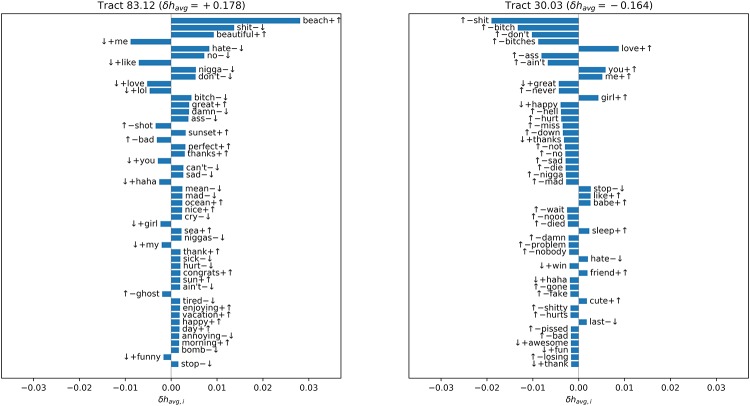
Word shift graph.